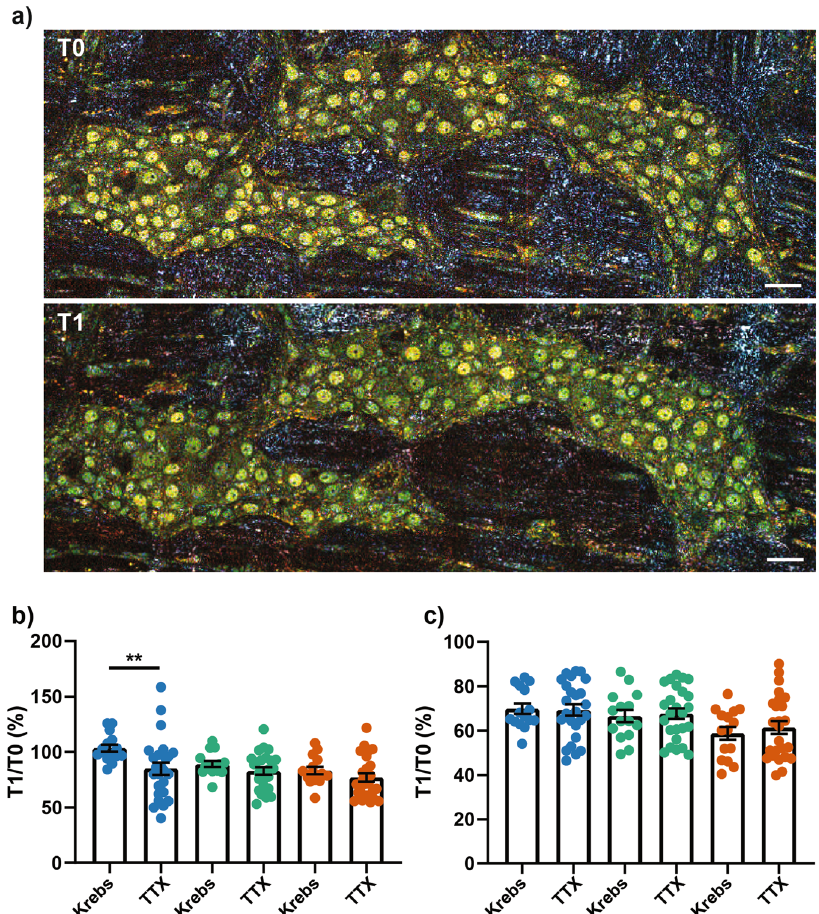
Fig. 5 Effect of tetrodotoxin on D-FFOCT signal. a D-FFOCT micrograph of the same ganglia before (T0) and after a 30 min treatment with 1 µ M of tetrodotoxin (T1). Scale bar: 30 µ m. b , c Ratio T1:T0 in percentage of the mean intensity for low (blue), medium (bluish green), or high (vermillion) range of frequency for a treatment with vehicle (Krebs) or tetrodotoxin (TTX). Mean intensity was calculated from the whole ganglia ( b ) or from the nuclear structure ( c ). Tetrodotoxin, n = 25 ganglia from 5 mice; Krebs, n = 15 ganglia from three mice. Mean value + / − SEM; Statistic: two-tailed Mann and Whitney t-test. ** p <